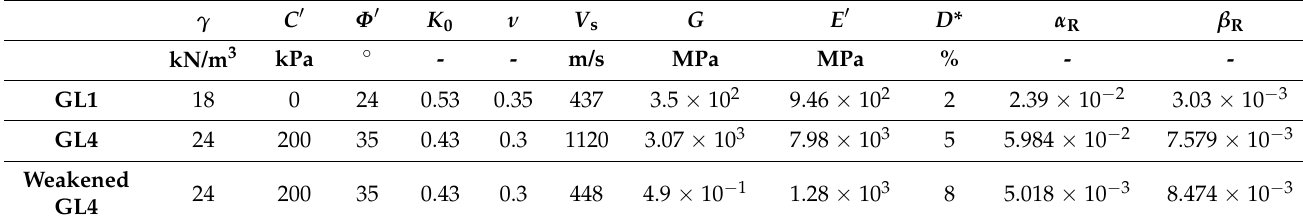
Table 2. Material parameters adopted in the FE simulations of the excavation.